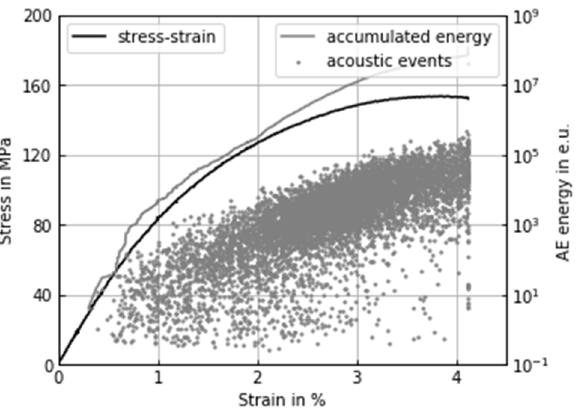
Figure 3. Stress–strain curve, acoustic energy and accumulated acoustic energy in energy units (1 e.u. ≙ 1×10 −21 J) of unloaded specimen.